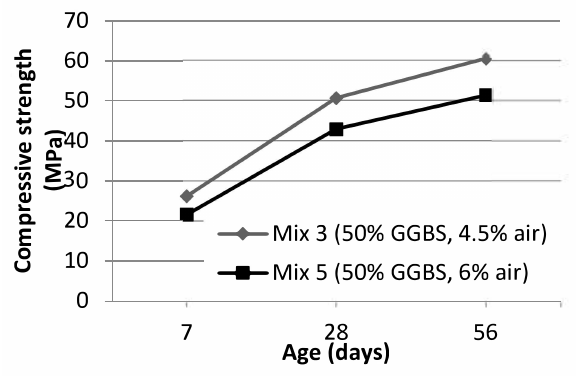
Figure 11. Compressive strength development of concretes with 50% GGBS, k = 0.6, cured at 20 ◦ C, and with di ff erent air